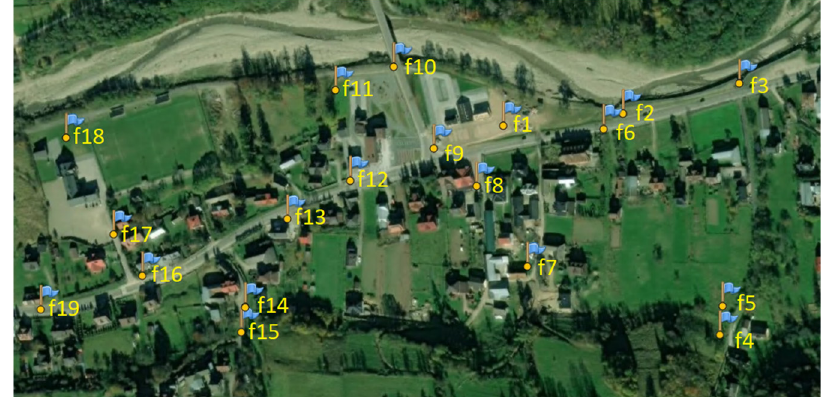
Figure 5. Distribution of ground control points in the surveyed area.